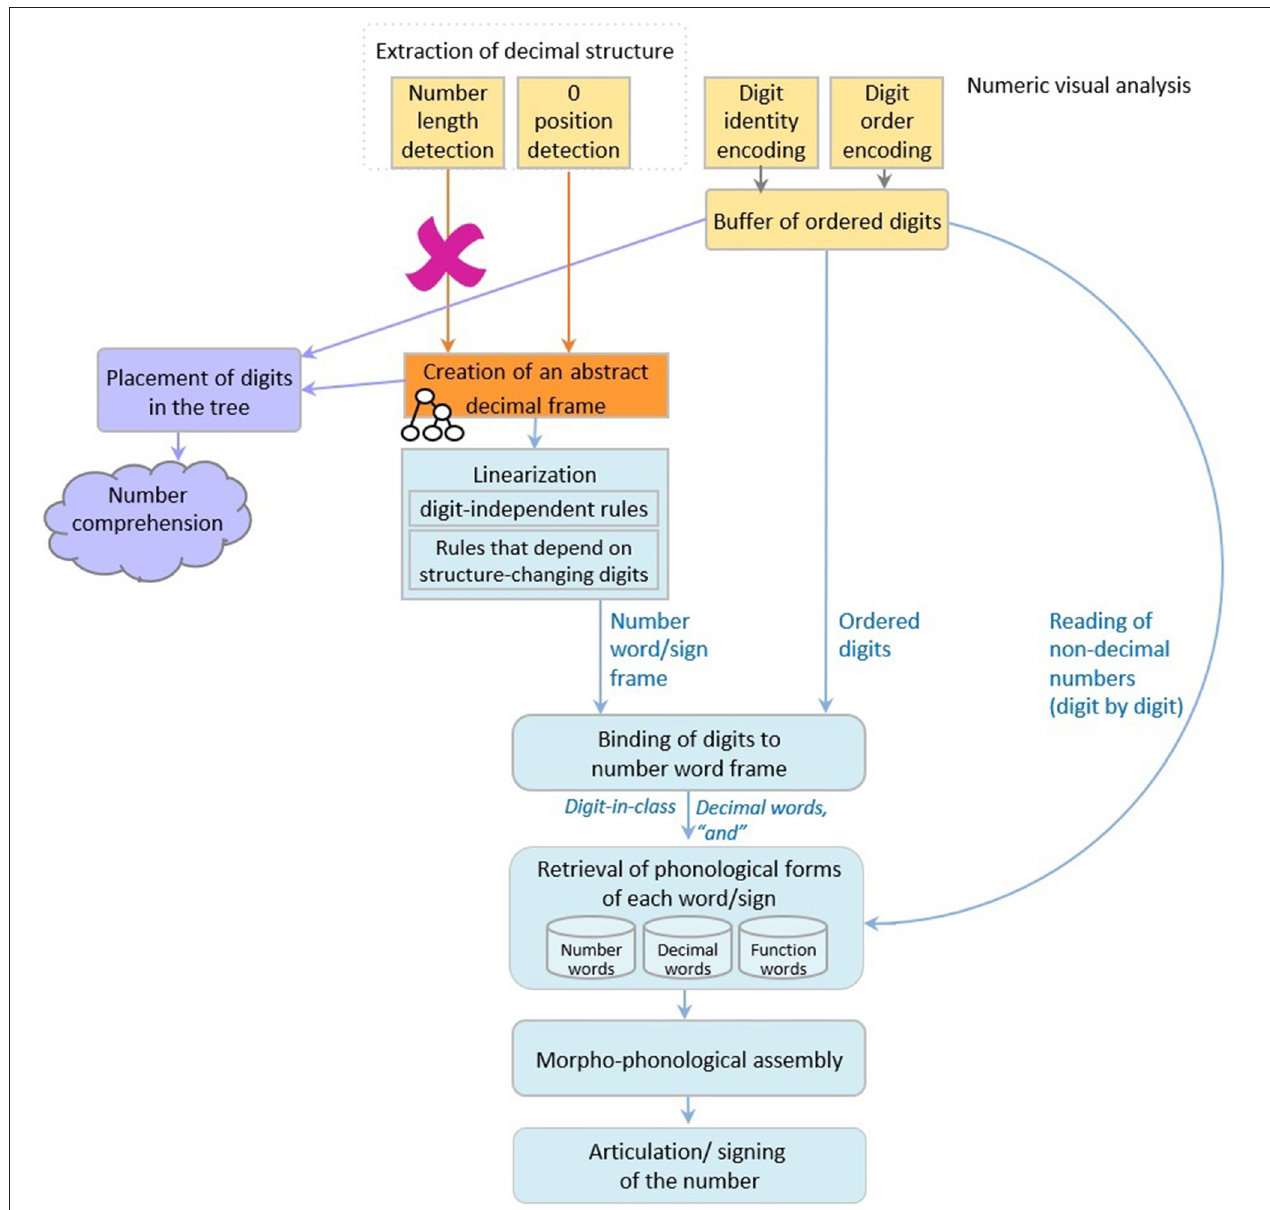
FIGURE 8 | A revised number reading model. Three modifications to Dotan and Friedmann’s (2018) model: (1) The decimal structure building component is non-verbal, and it is shared with comprehension processes, (2) an addition of a non-decimal number reading route, (3) triplet parsing is no longer part of the numeric-visual analysis